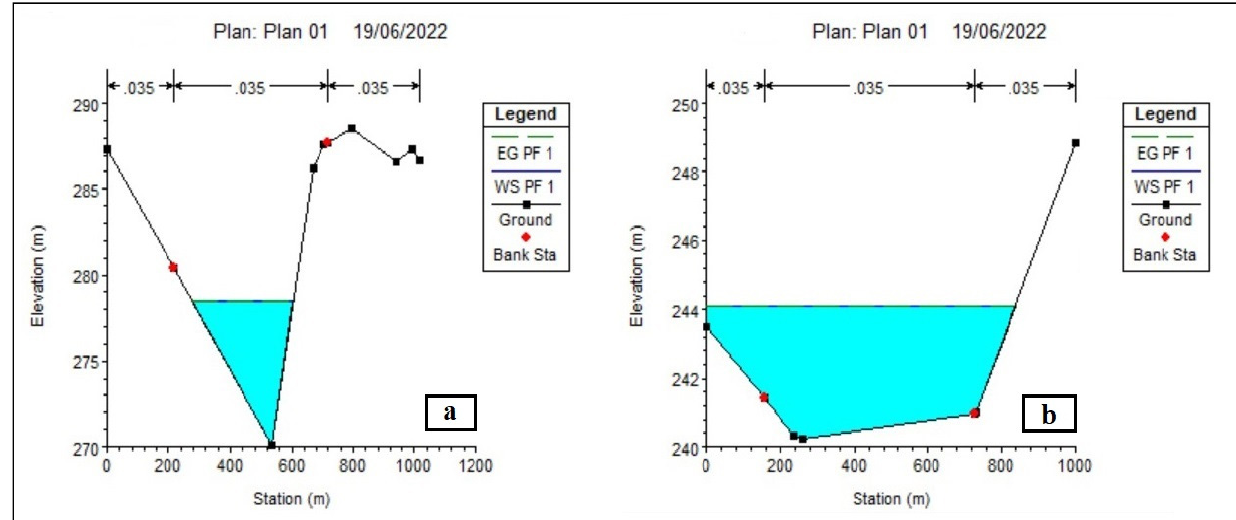
Figure 12. River cross-sections for 2018 ( a ) upstream and ( b ) downstream.